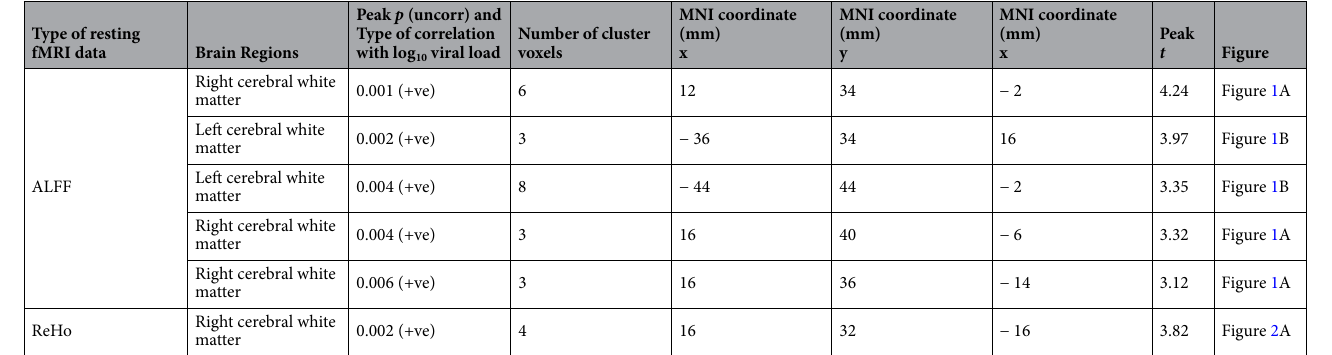
Table 3. Correlation of resting fMRI data with viral load. Brain regions masked with significantly higher regional neuronal activity in the pediatric HIV patients compared to healthy controls, showed positive correlation (peak uncorrected p < 0.01, cluster size ≥ 3) of log 10 viral load with regional neuronal activity in the 11 pediatric HIV patients. + ve indicate positive correlation and − ve indicate negative correlation.